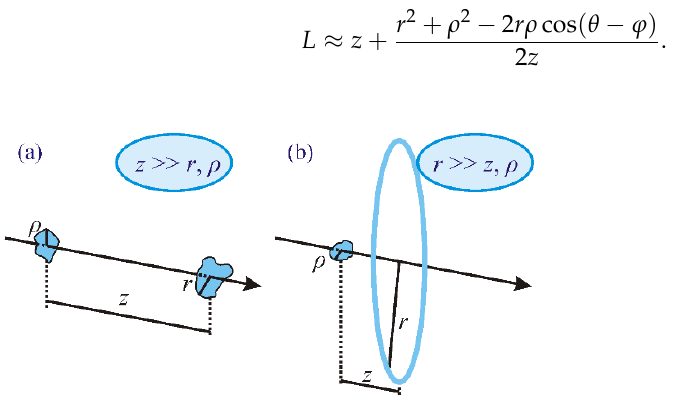
Figure 1. ( a ) Paraxial approximation: propagation distance z is much larger than transverse coordi- nates ρ and r in the input and output planes; ( b ) huge-ring approximation: transverse coordinate r in the output plane is much larger than the propagation distance z and the transverse coordinate ρ in the input plane.